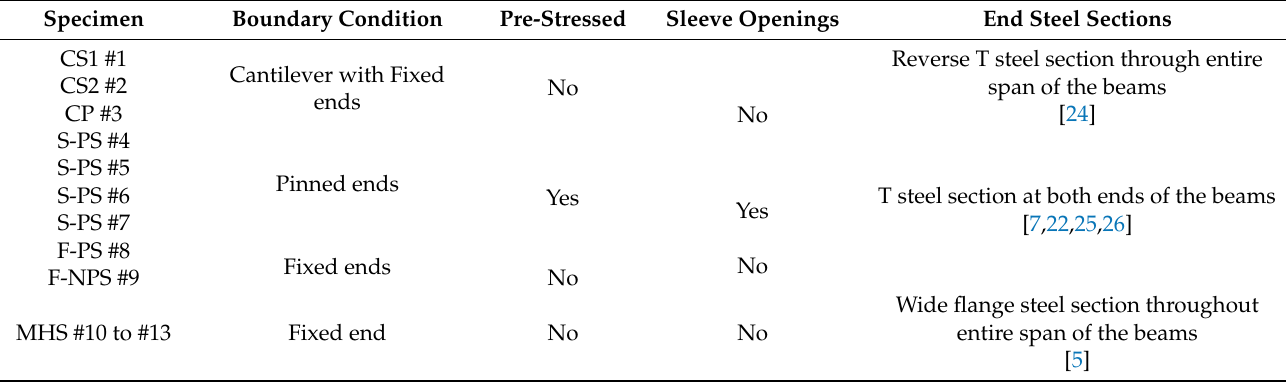
Table 1. Summary of specimens for estimation of post-yield deflection.